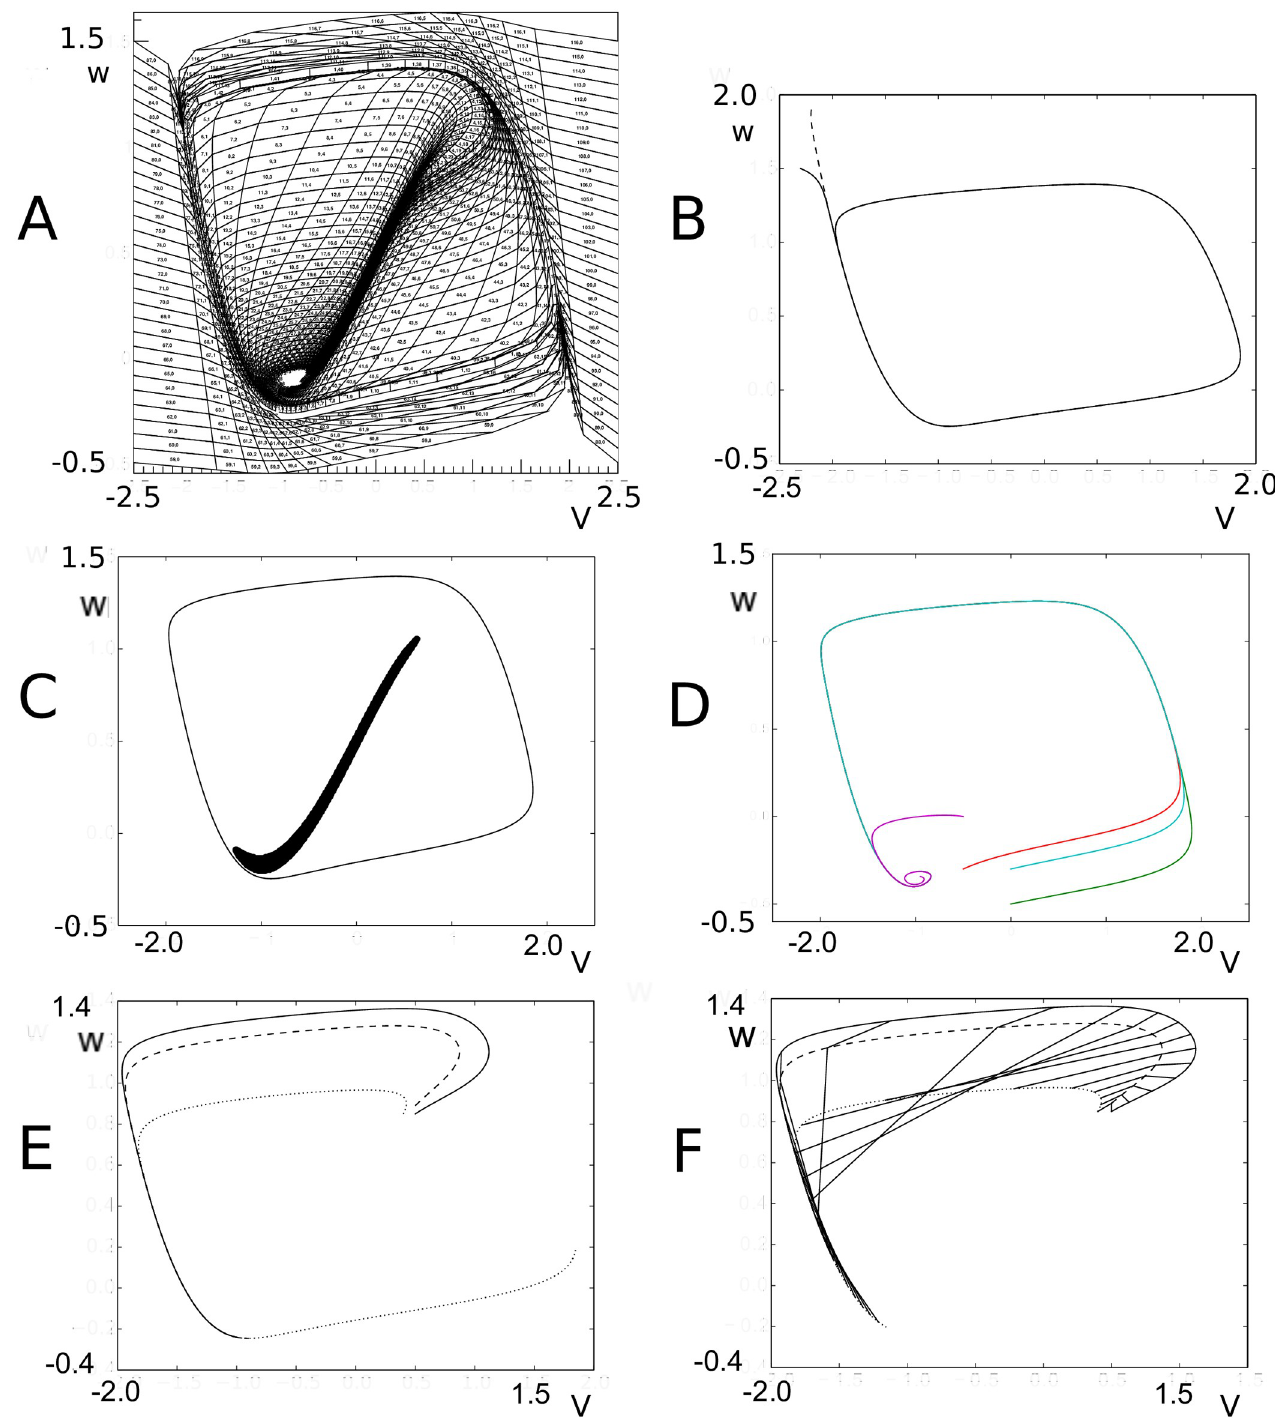
Fig 14. A: The numbered mesh provides a coarse overview of the dynamics of the system, whereas we run our simulations using the much finer mesh. B: Different trajectories in the Fitzhugh-Nagumo model (as shown by solid and dashed lines) can merge before reaching the limit cycle. C: The region of the Fitzhugh-Nagumo model tiled with stationary cells; limit cycle is shown for reference. D: Sample trajectories in the Fitzhugh-Nagumo model in the parameter regime where the system tends to a fixed point. E: Trajectories that begin close to each other have the potential to diverge rapidly. F: Attempting to build cells from these trajectories can lead to “stretched” cells that intersect other